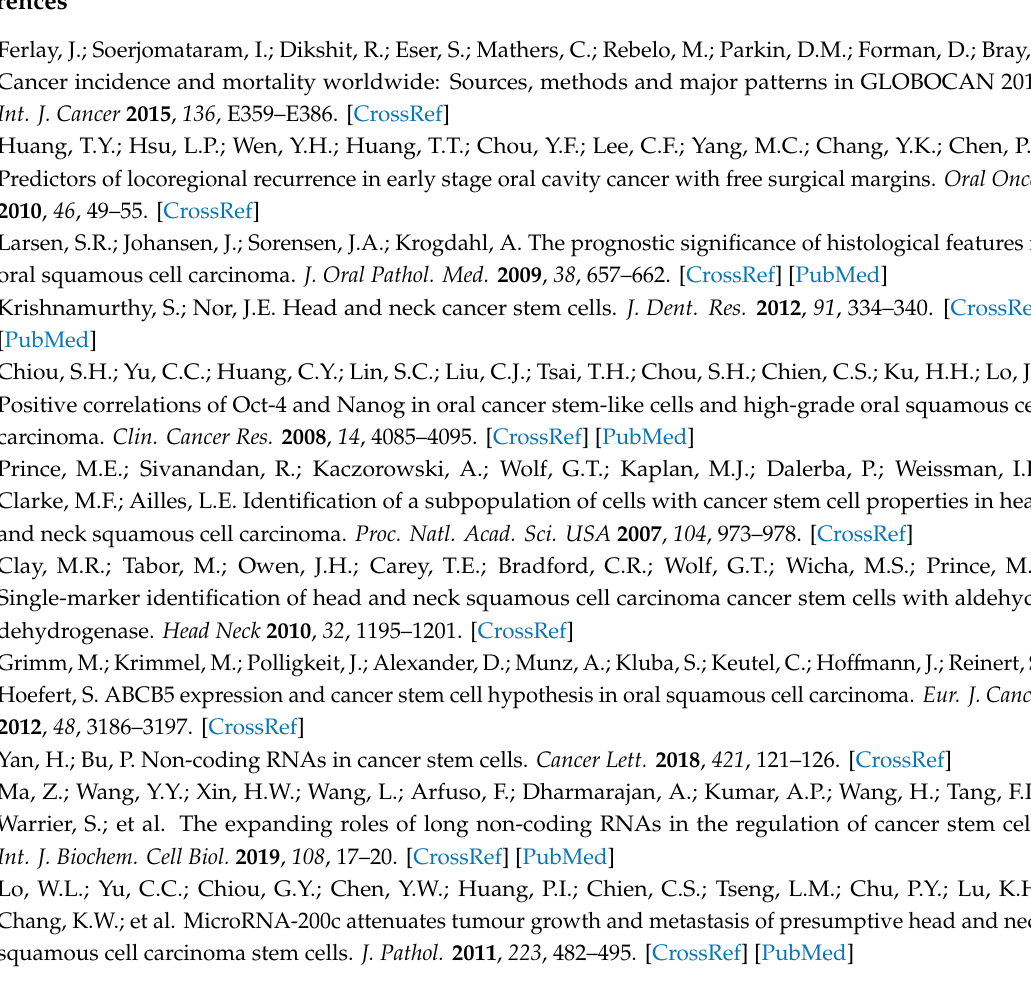
Figure S1: (A) Silencing LINC00963 decreased the expression of ABCB5 protein level in OSCC-CSC by western blotting. TheamountofGAPDHproteinofdi ff erentcrude cellextractwasreferredasloadingcontrol. (B)Thewhole blot (uncropped blots) of Supplementary Figure S1A. Table S1: Clinicopathological parameters in OSCC